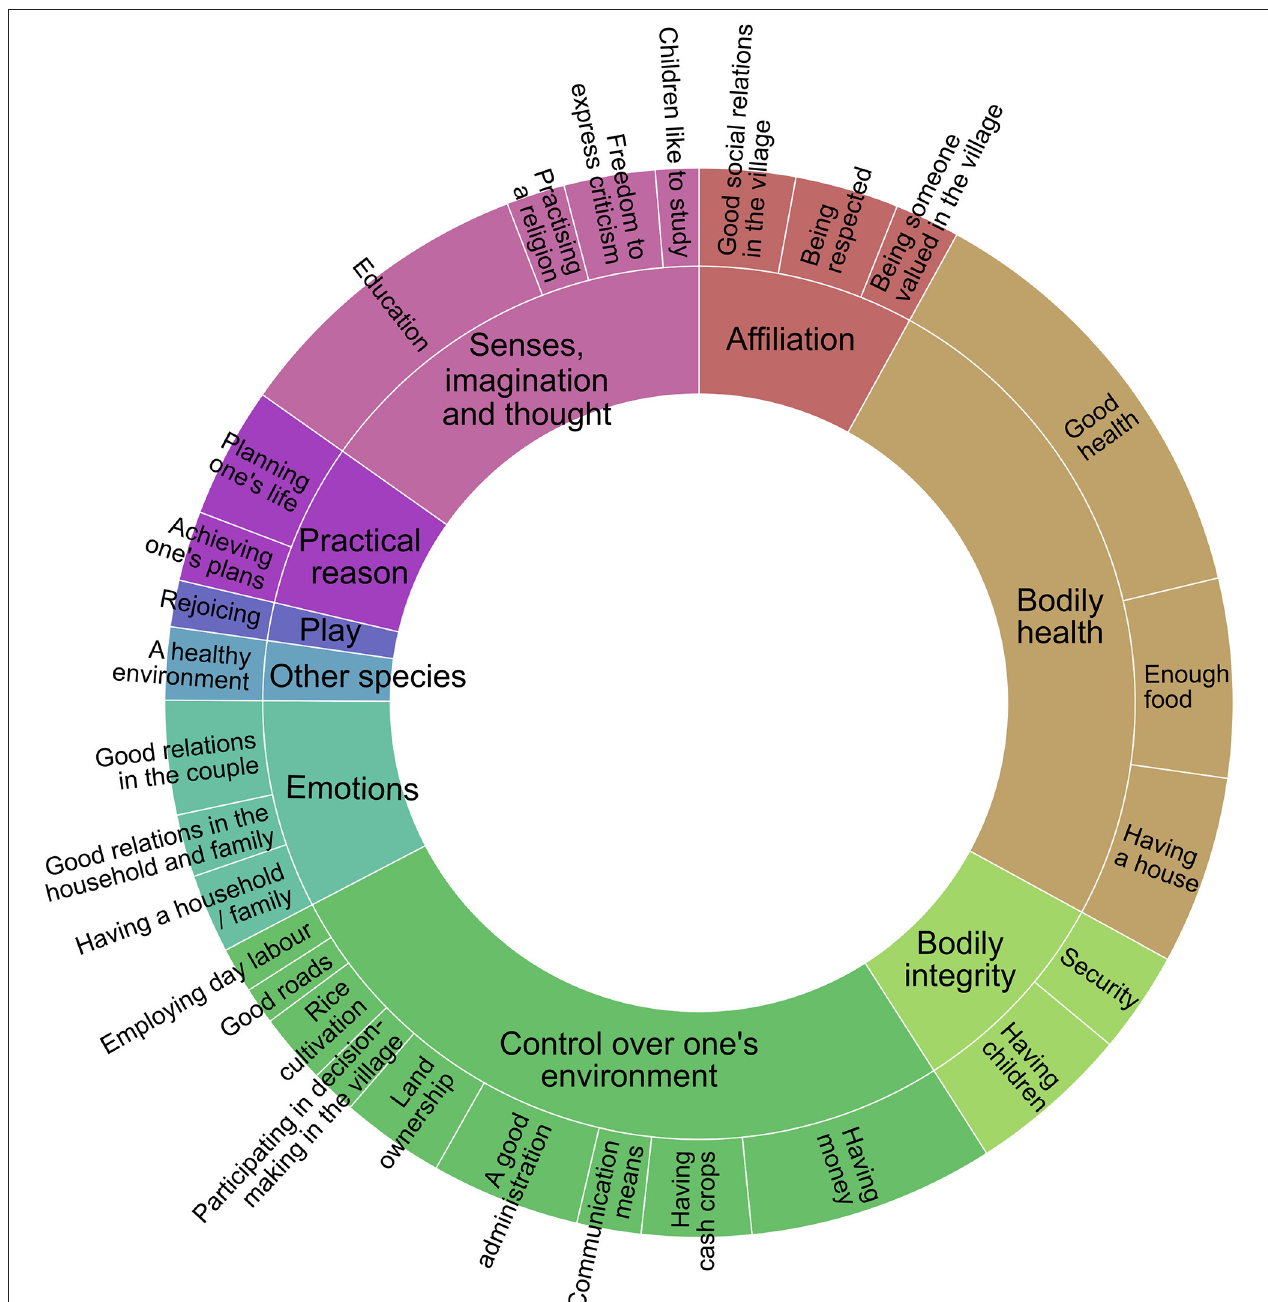
FIGURE 3 | Well-being components (outside circle) grouped by the central capability (inside circle) they most relate to. Wedge size of well-being components corresponds to frequency-weighted score obtained by the component across villages and genders. For reasons of space, only components with a minimum frequency-weighted score of 1 are displayed. See Supplementary Material 2 for more details. Figure created with RAWGraphs (Mauri et al.,